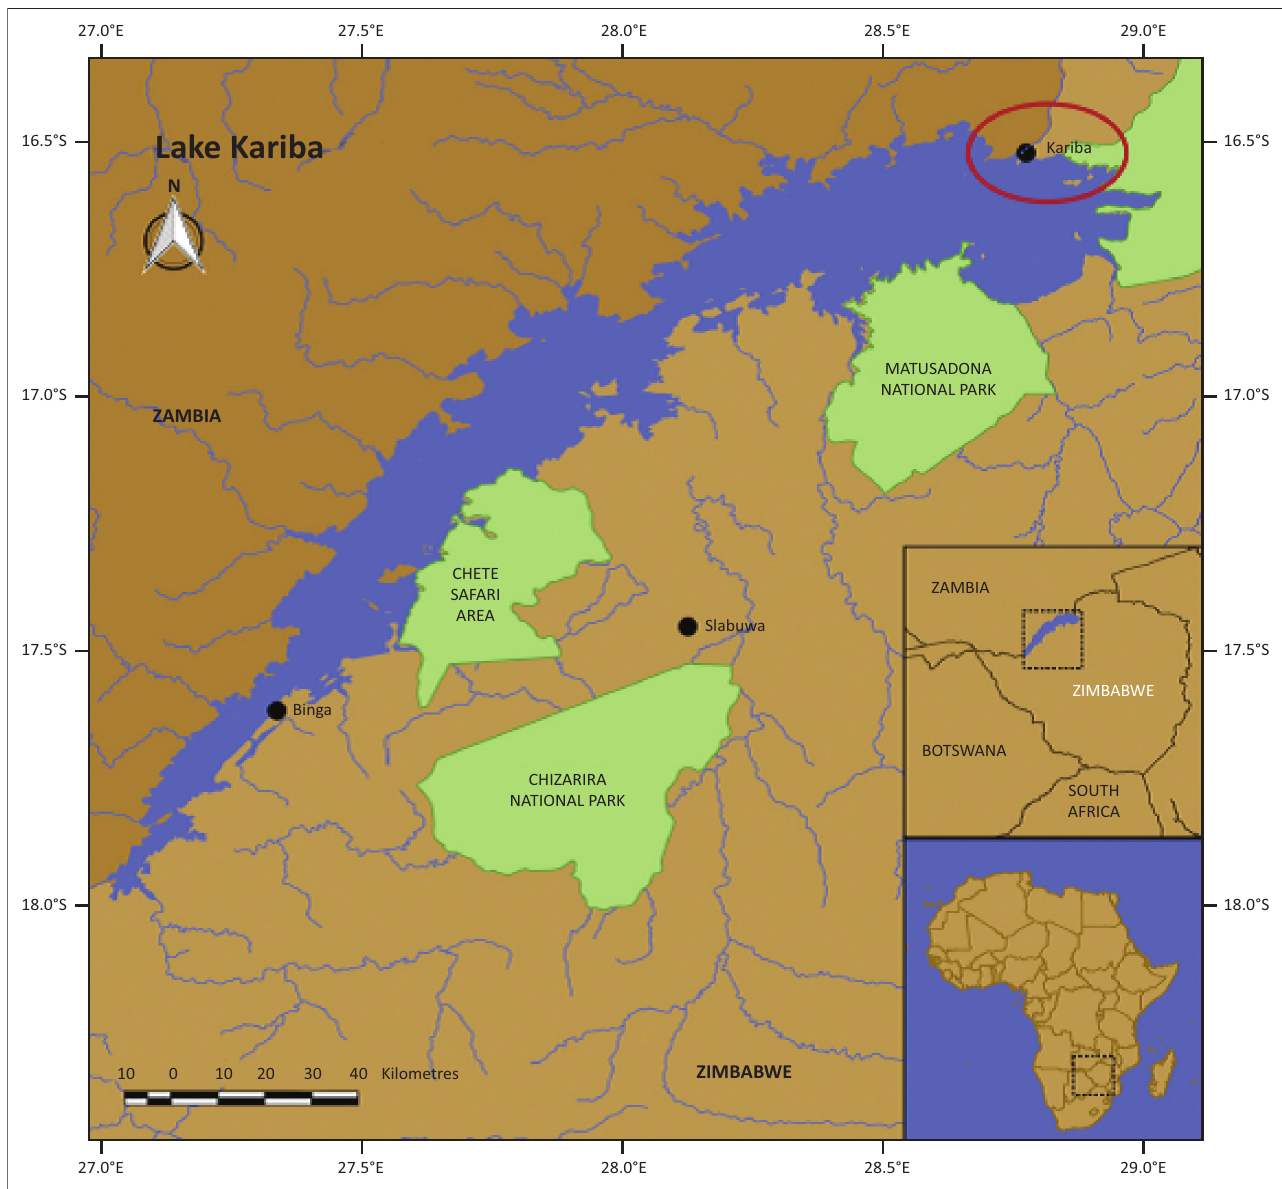
FIGURE 1: A map of Lake Kariba showing the location of the Sanyati